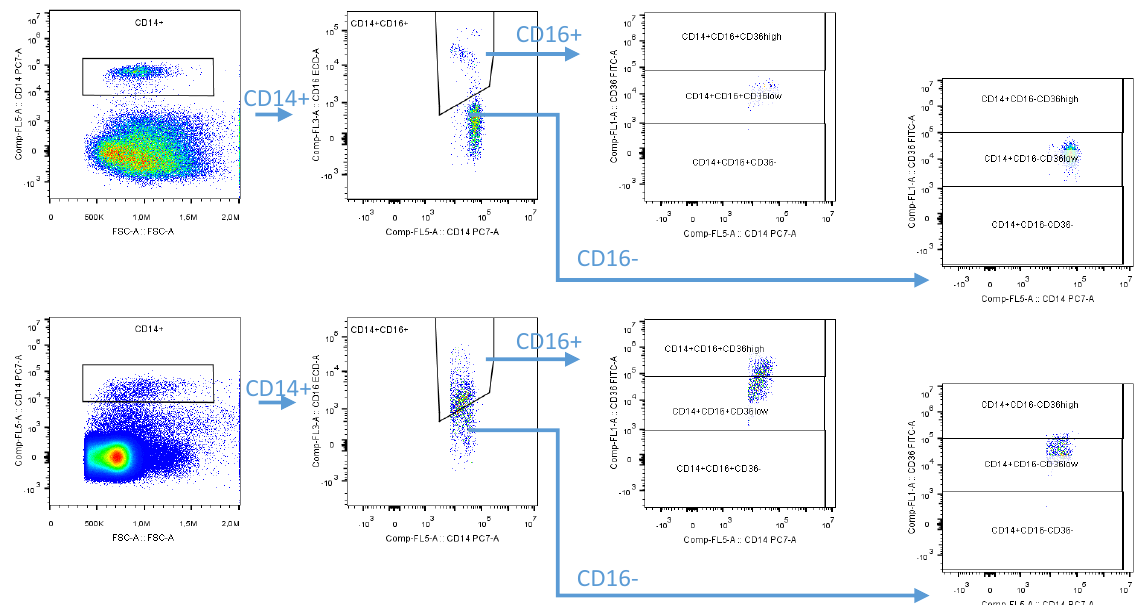
Figure 1. Blood gating strategy and the isolated stromal vascular fraction of the visceral adipose tissue. After gate-out debris and non-singlets, only viable cells were included in the analysis. Viable CD14+ cells were divided into CD16+ and CD16- subpopulations based on the blood sample gate where the transition between the CD16+ and CD16- population was obvious. Next, both cell populations were further differentiated according to CD36 expression into CD16-, CD36low, and CD36high. In this manner, we defined the three main adipose tissue macrophage subtypes as follows: pro-inflammatory (CD14+CD16+CD36high), transient (CD14+CD16+CD36low), and anti-inflammatory